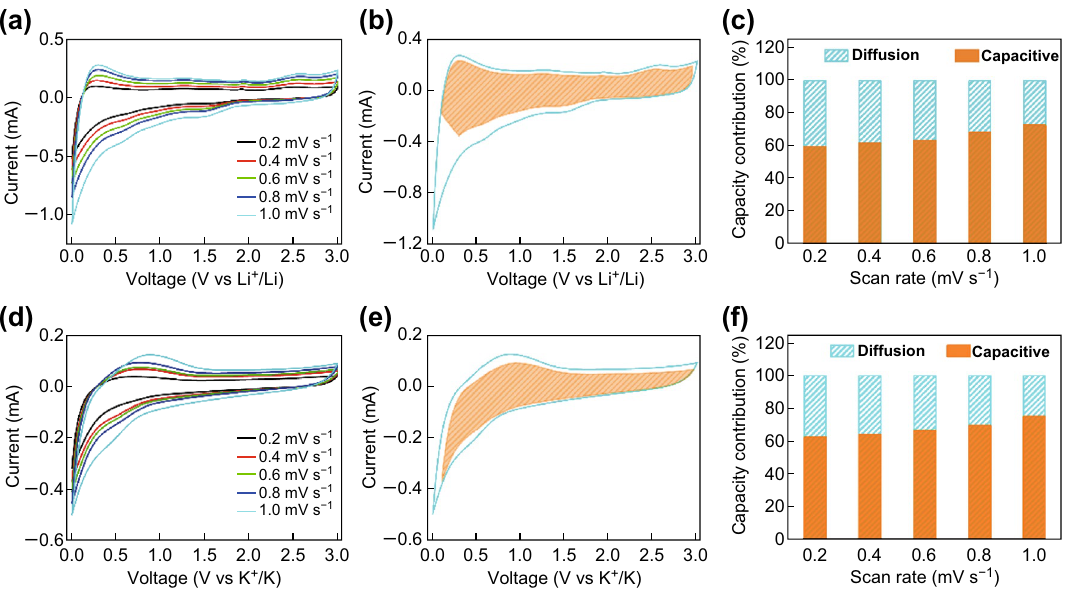
Fig. 6 a , d CV curves of NPG at different scan rates. b , e CV profiles showing the capacitive contribution (filled part) of NPG at a scan rate of 1 mV s −1 . c , f Diagram of the capacitive contribution to the total capacity at different scan rates. The ( a – c ) and ( d – f ) panels correspond to LIBs and PIBs,